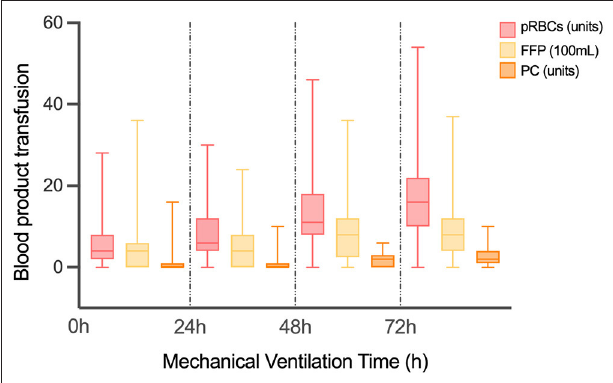
FIGURE 2 | The volume of different transfusion in patients with different MVT. MVT, mechanical ventilation time; pRBCs, packed red blood cells; FFP, fresh frozen plasma; PC, platelet